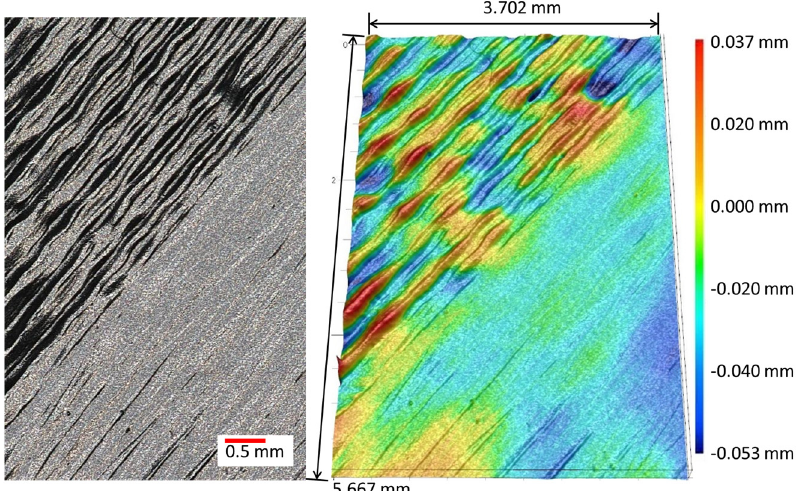
Figure 8. Specimen L3, Layer 8 (550 µm design thickness), 40× optical image ( left ), and 3D height data image ( right ). This image displays a transition in the scan lines melt quality and surface roughness within a single layer.